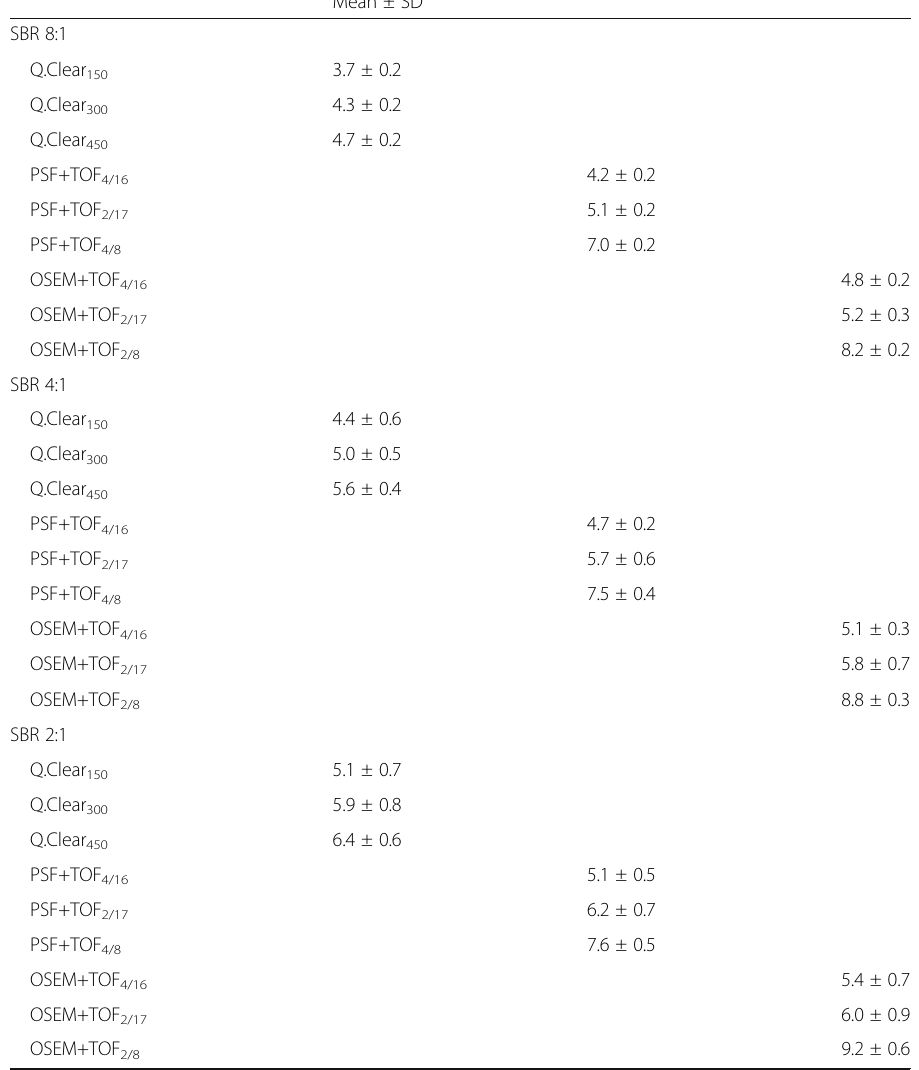
Table 1 Reconstructed spatial